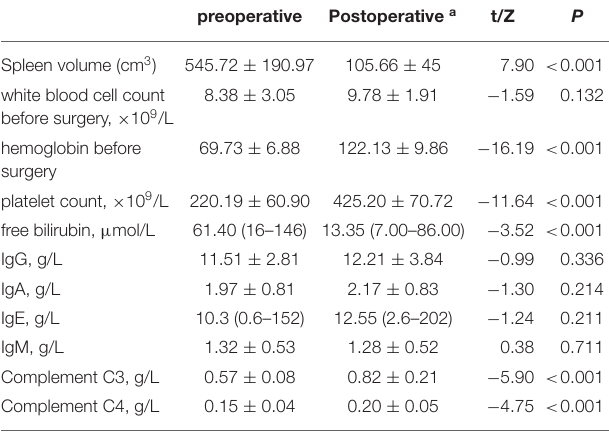
TABLE 3 | Comparison of clinical indicators before and after surgery in patients undergoing